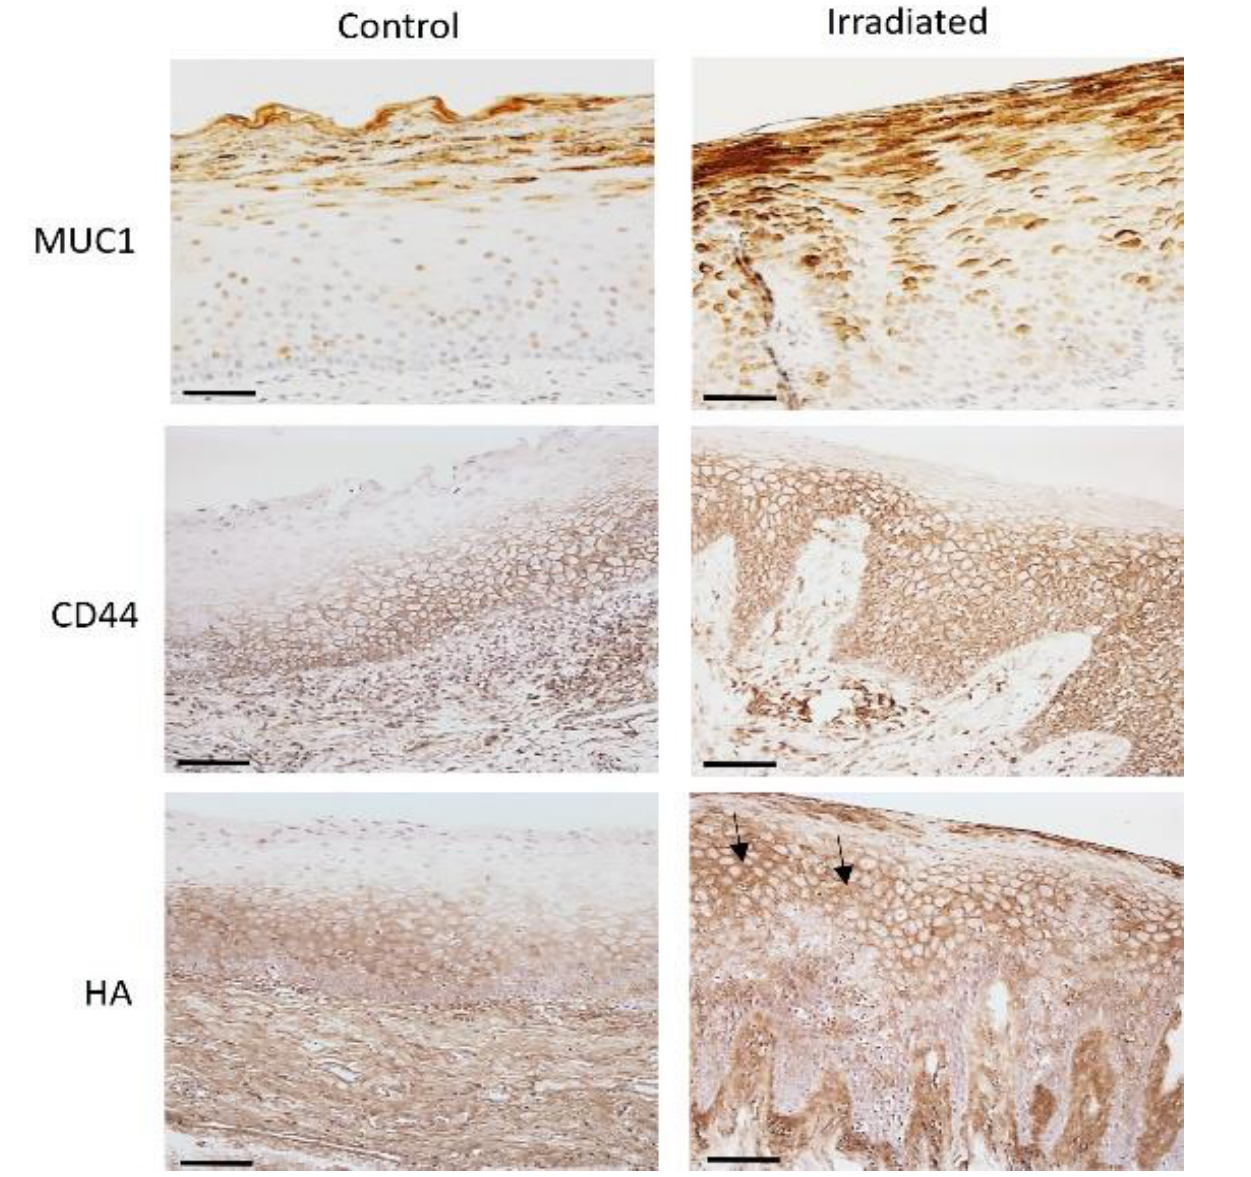
Figure 2. MUC1 is expressed in the superficial layers of the control oral epithelium. Increased expression of MUC1 showing membrane and cytoplasm staining in all the layers of epithelium is observed in the irradiated epithelium. Immunolocalization of HA and CD44 is limited to pericellular and faint intracellular staining in basal and intermediate layers of controls. Immunohistochemistry images of HA and CD44 show a gradual increase in staining intensity in irradiated epithelium together with peri- and intracellular staining. The intermediate cells show cytoplasmic HA staining (arrows) in the irradiated epithelium (Bar = 100 µm).